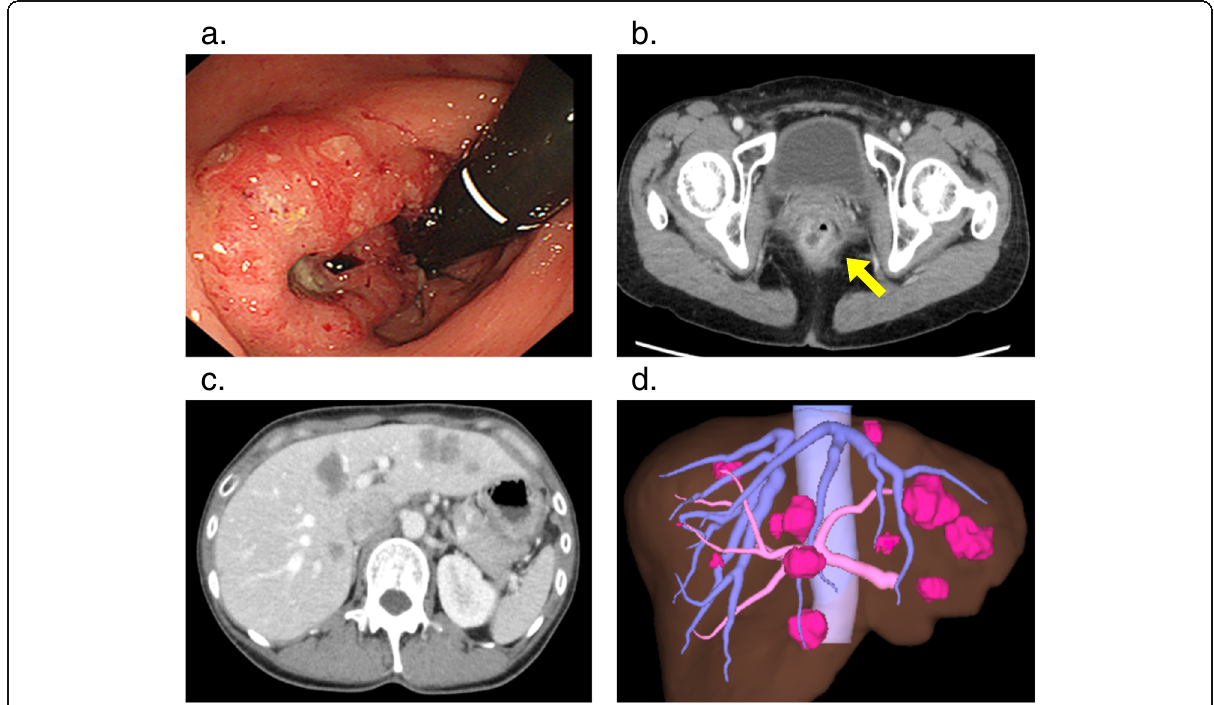
Fig. 1 CT imaging and a colonoscopy before neoadjuvant chemotherapy. a Primary rectal cancer on a colonoscopy. Type 2 rectal carcinoma. No bleeding or occlusion is observed. b A xial view of primary rectal cancer (arrow) on CT. Contrast-enhanced wall-thickening (20 mm) is seen in the lower rectum. There were no signs of occlusion. c Axial view of multiple bilobular liver metastases on CT. d Multiple liver metastases on 3- dimentional image from CT. Lesions are bilobular. CT, computed